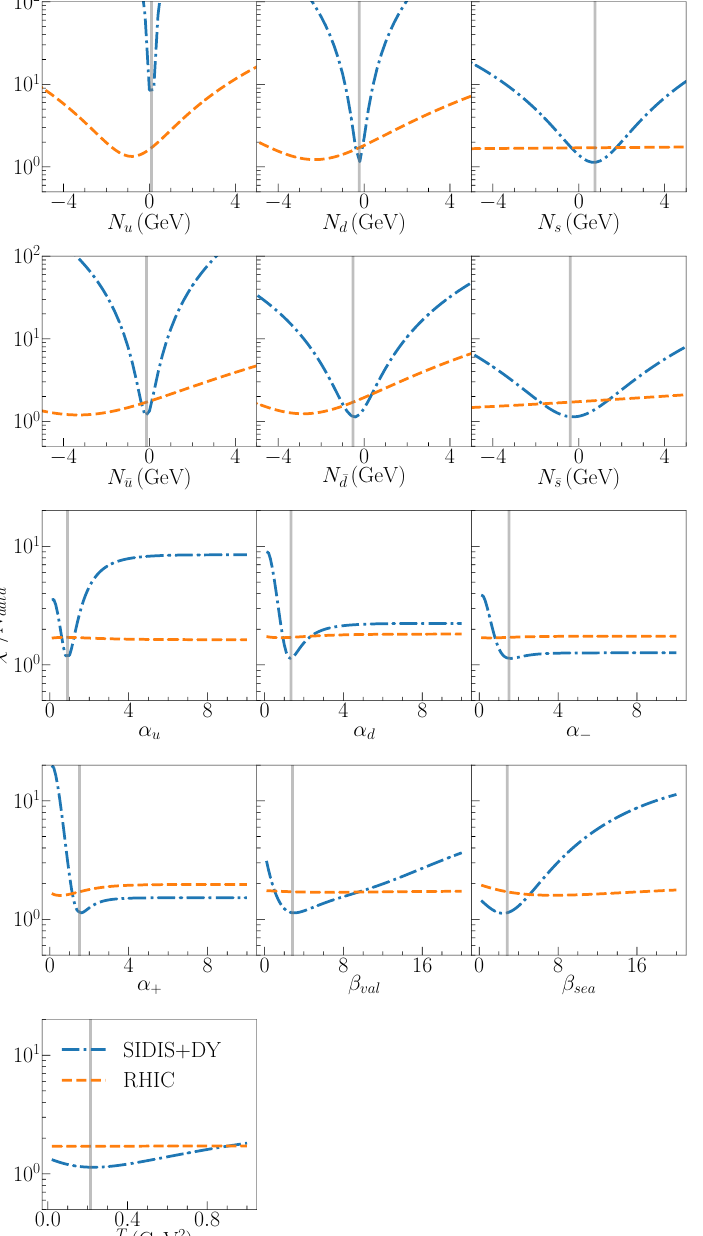
Figure 13 . The distribution of χ 2 /N data for each parameter. In each subplot, we vary each parameter about the central value while keeping all other parameters fixed to the optimal values determined by the fit. The gray line is the central value determined from the